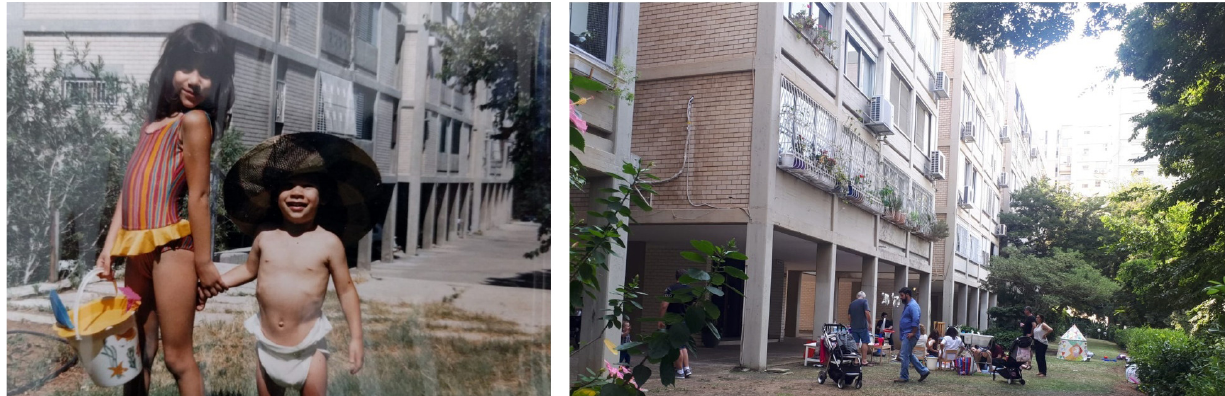
Figure 13. Birthday parties and children’s play on the upper lawn. Sources: Right photo by the authors, 2019; left photo courtesy of N. L., ca. 1985.